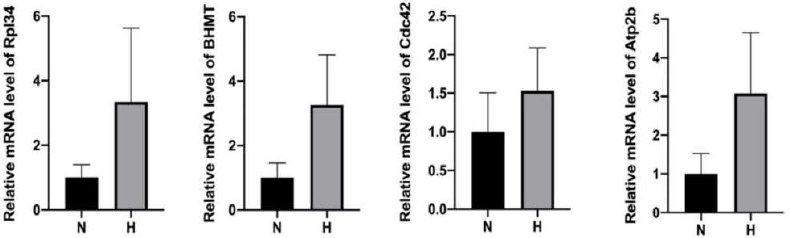
Figure 6. qPCR analysis revealed an enhancement of mRNA in HP-EVs of select upregulated proteins within HP-EVs. n = 4, p = 0.1143 HP group vs. normal group for Rpl34 mRNAs, p = 0.2363 HP group vs. normal group for BHMT, p = 0.3322 HP group vs. normal group for Cdc42, p = 0.1560 HP group vs. normal group for Atp2b. MRNA levels are all expressed as means ± SD .